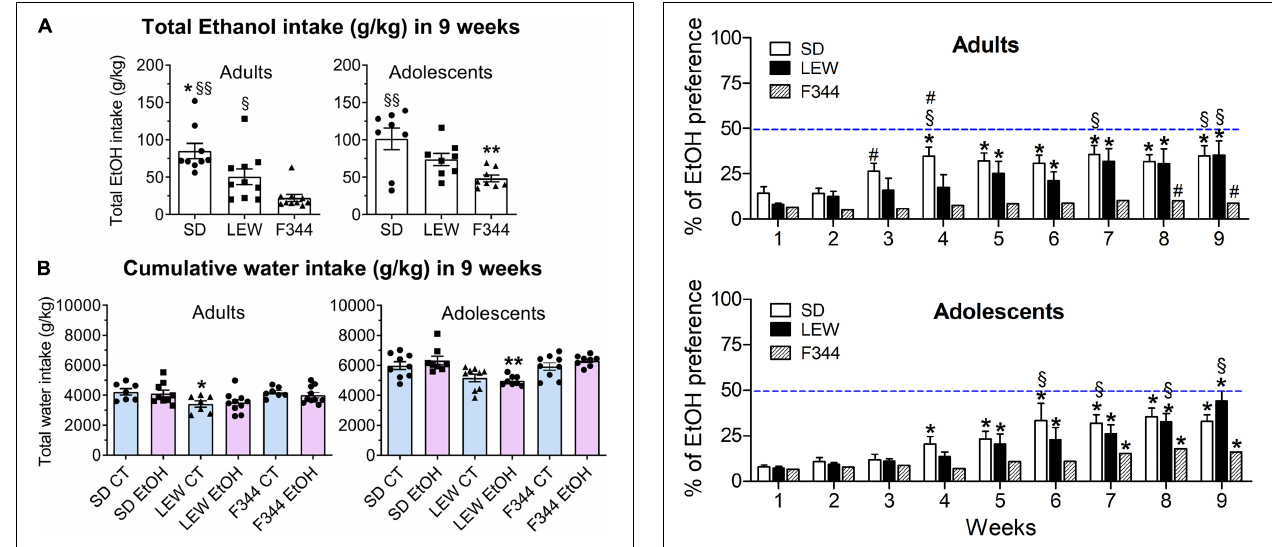
compared with the other two strains, notably vs. F344